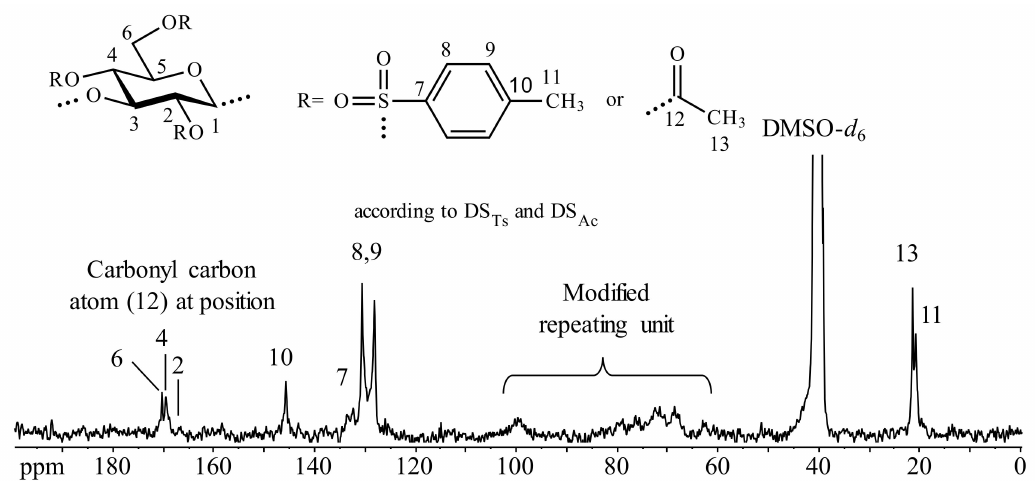
Figure 4. 13 C-NMR spectrum of peracetylated β -1,3-glucan p -toluenesulfonic acid ester (sample 3g ) degree of substitution (of tosyl groups, DS Ts , 1.02, of acetyl groups, DS Ac ) recorded in dimethyl sulfoxide (DMSO)- d 6